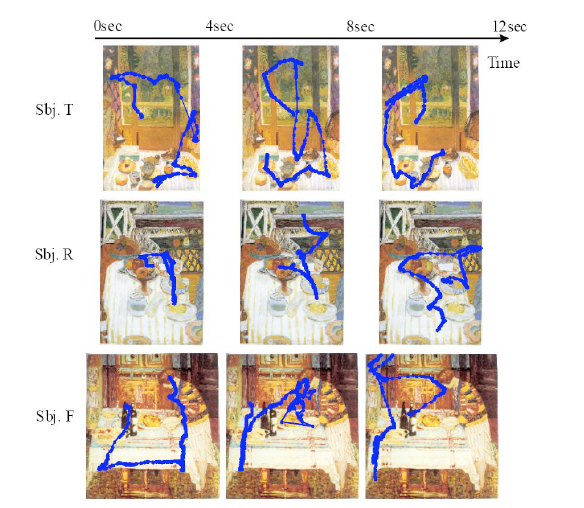
Figure 5. Additional examples of the extended scanpath phenomena for different subjects and paintings: "Dining room overlooking the garden", 1930, subject T; "the White tablecloth," 1926, subject R and again "After the meal", 1925, subject F. The characteristic hidden figures, carefully placed by Bonnard in the periphery of the image, are attended only during the last